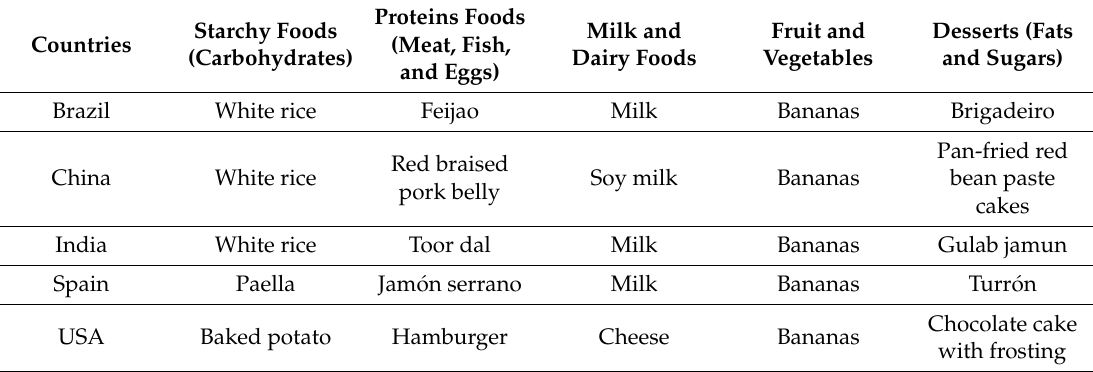
Table 2. Food items that were used for each food group in each of the five